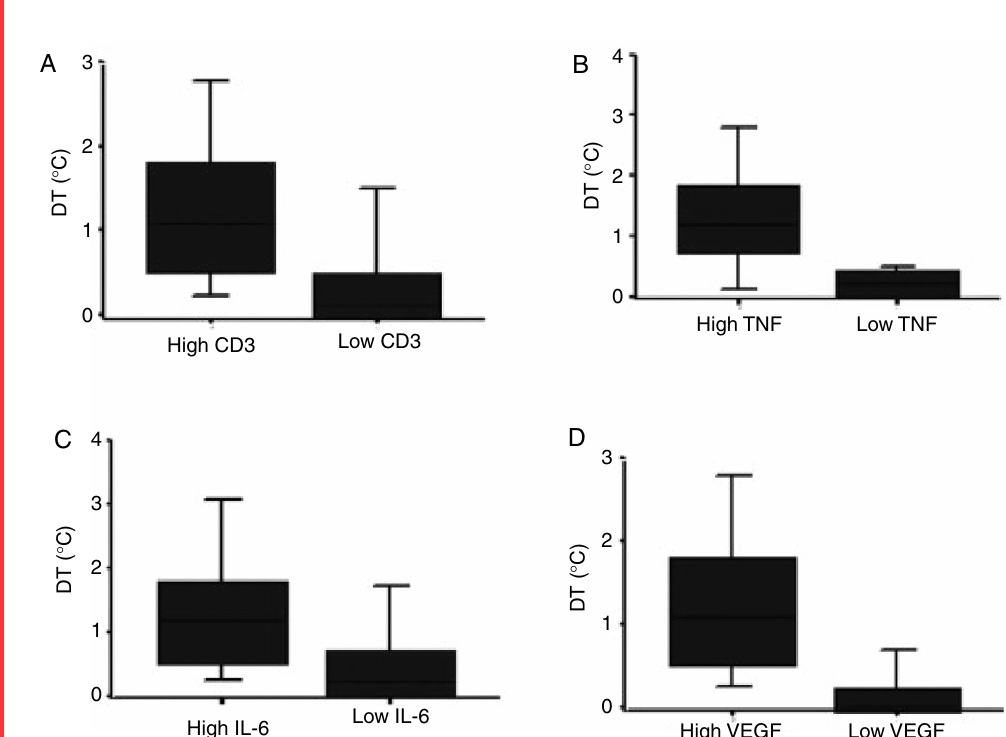
Figure. 3 Active inflammation in aortic valve leaflets measured by temperature difference in patients with aortic stenosis with intense compared to low expression of (A) CD3, (B) TNF- α , (C) IL-6, and (D) vascular endothelial growth factor (VEGF) (from Toutouzas et al. reference